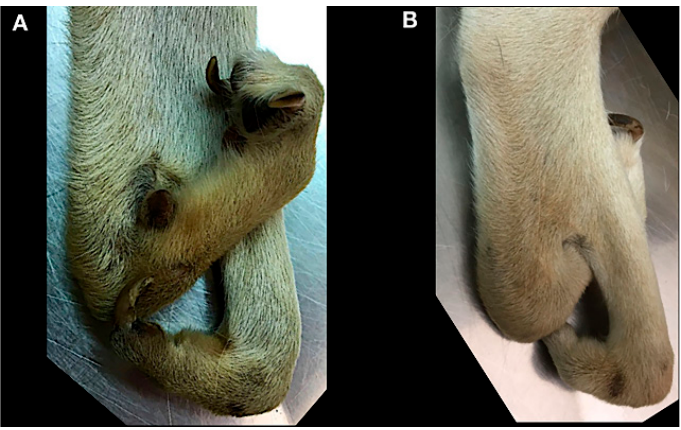
Figure 4. Case 2. Medial ( A ) and lateral ( B ) views of the right forelimb.